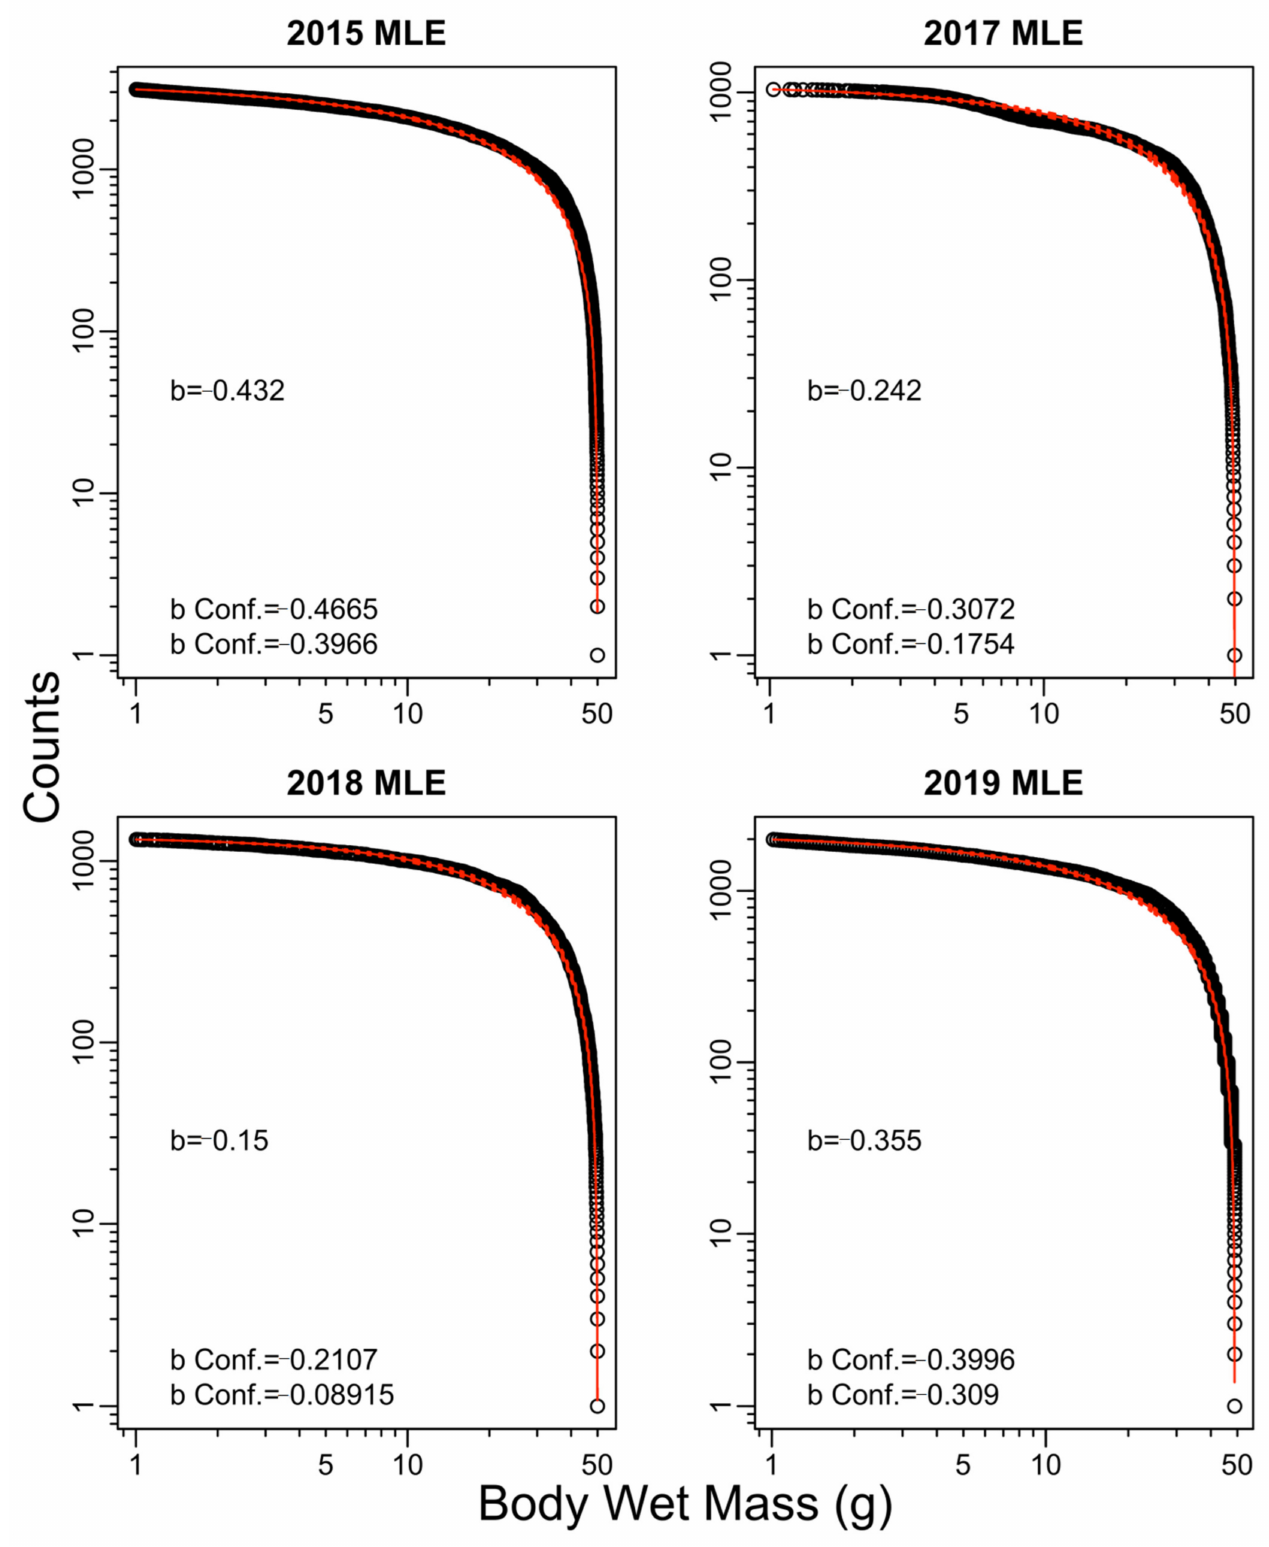
Figure A9. Fish SS with counts and body wet mass (g) fitted using the maximum likelihood estimate of exponent b with the 95% confidence interval of b based on the tracked-echo group (TEG) from hydroacoustic surveys for